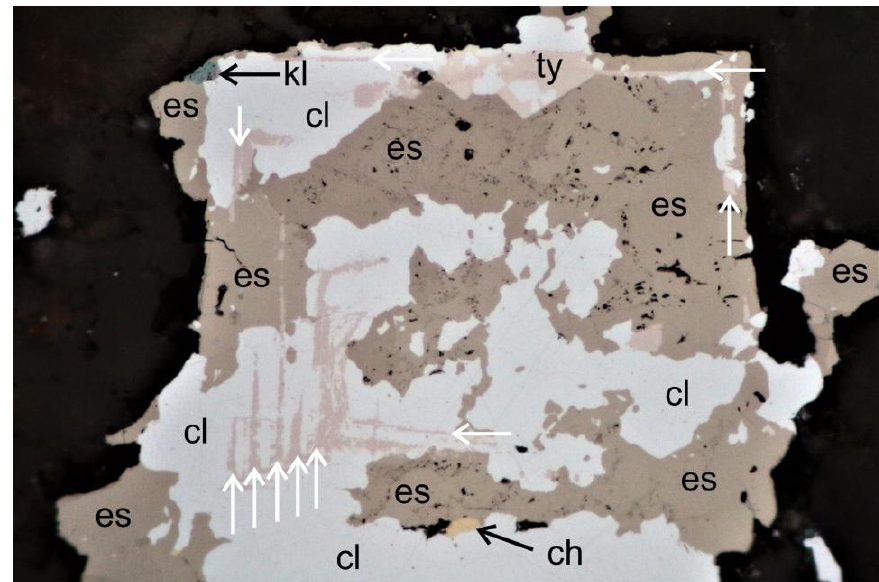
Figure 10. Detail from Se-vein Type-3: Originally cubically shaped and oscillatory grown krut’aite-(g1) crystal traced by thin zones of trogtalite-(g1) (see white arrows). Other replacement and alteration products are klockmannite-(g2) (kl), eskebornite-(g2) (es), clausthalite-(g2) (cl), and chalcopyrite-(g3) (ch). Reflected light image, 200-μm-wide, plane polarized light.